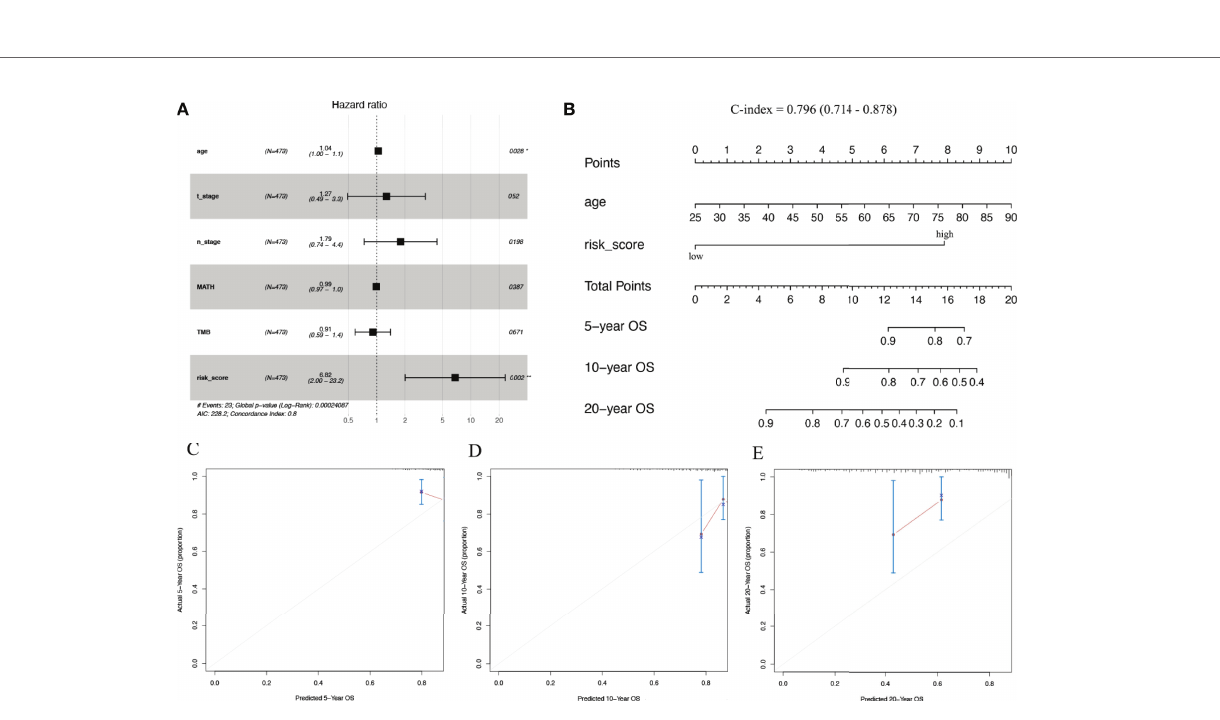
FIGURE 7 | Predictive nomogram construction. (A) Hazard ratio and p ‐ value of the clinicopathological factors and risk scores involved in multivariate Cox regression in the TCGA cohort. (B) Nomogram to predict the 5-year, 10-year, and 20-year overall survival rate of patients with stage N+M0 BRCA. (C – E) Calibration curve for the nomogram. BRCA, breast cancer.